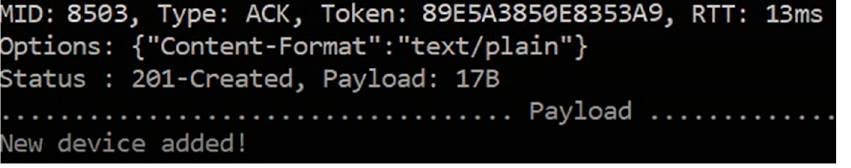
Figure 23 . Adding a new device results in the corresponding message: new device added Figure 23. Adding a new device results in the corresponding message: new device added. Figure 23. Adding a new device results in the corresponding message: new device added. Figure 23. Adding a new device results in the corresponding message: new device added.